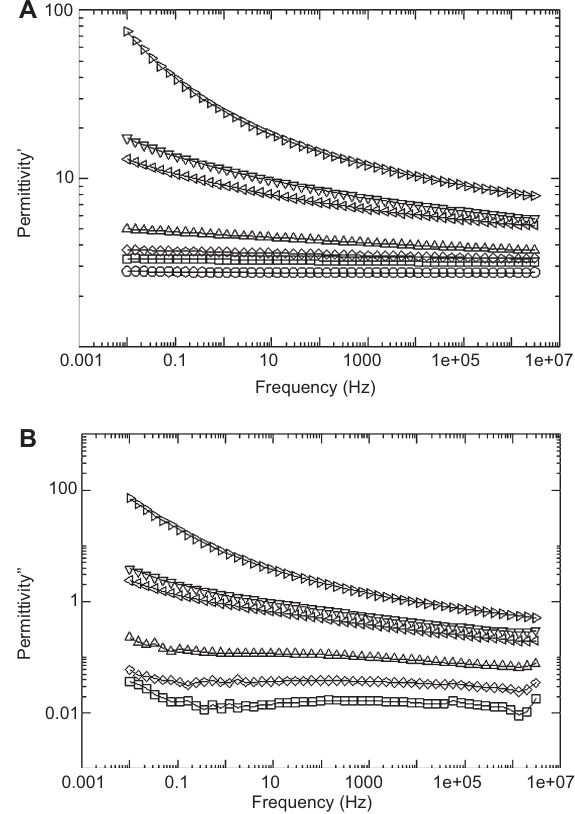
Figure 6 Real permittivity (A) and imaginary permittivity (B) of PS/GTR at 30 ° C in relation to frequency: ○ PS; □ PS+5% GTR; ◊ PS+10% GTR;  PS+20% GTR;  PS+40% GTR;  PS+50% GTR;  PS+70%